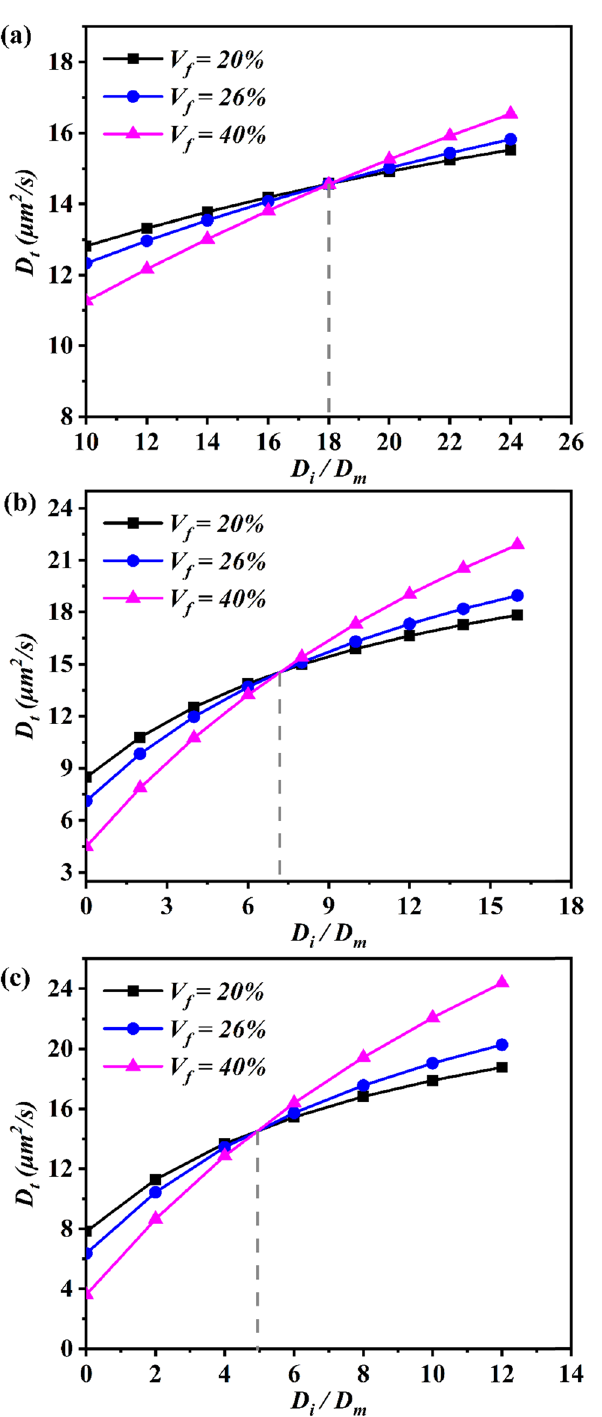
Figure 8: Evolution of transverse di ff usivity of composites ( D t ) vs the ratio of the di ff usivities of the interphase and matrix D D i m ( / ) , where interphase is ( a ) 200 nm, ( b ) 400 nm, and ( c ) 800 nm.